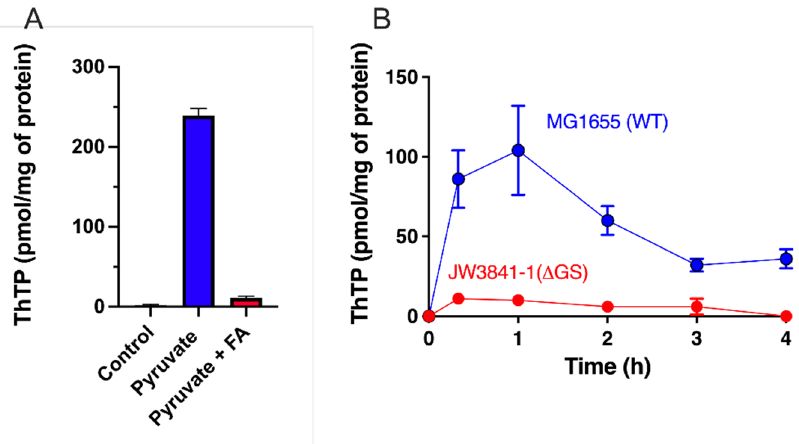
Figure 2. Importance of the pyruvate–glutamine axis for ThTP synthesis in E. coli . ( A ) Inhibition of ThTP synthesis by fluoroacetate (FA). E. coli cells from the BL21 strain were grown in LB medium and then transferred into a M9 minimal medium (devoid of amino acids) for 20 min (37 °C, 250 rpm) in the absence or the presence of either pyruvate (10 mM) or pyruvate (10 mM) + fluoroacetate (10 mM) and ThTP was determined by HPLC [28]. ( B ) ThTP synthesis is strongly decreased in a strain specifically deficient in glutamine synthetase (JW3841-1 derived from parent strain MG1655/K12 - ATCC 47076). Both strains were grown in minimal medium in the presence of 10 mM D-glucose for the indicated times and ThTP was determined as above. Single gene deleted strain JW3841-1 [46] (CGSC # 10775) was obtained from the Genetic Resource Center (Yale University, New Haven, CT, USA) (data are from [47] and expressed as mean ± SD).